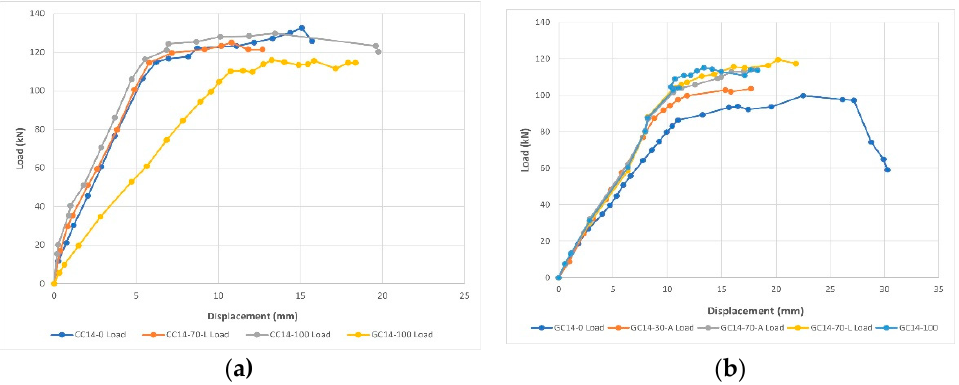
Figure 9. ( a ): The load-displacement curves of geopolymer and ordinary Portland cement beams; and ( b ): the load-displacement curves of GRAC with different ratios and replacement patterns [50].